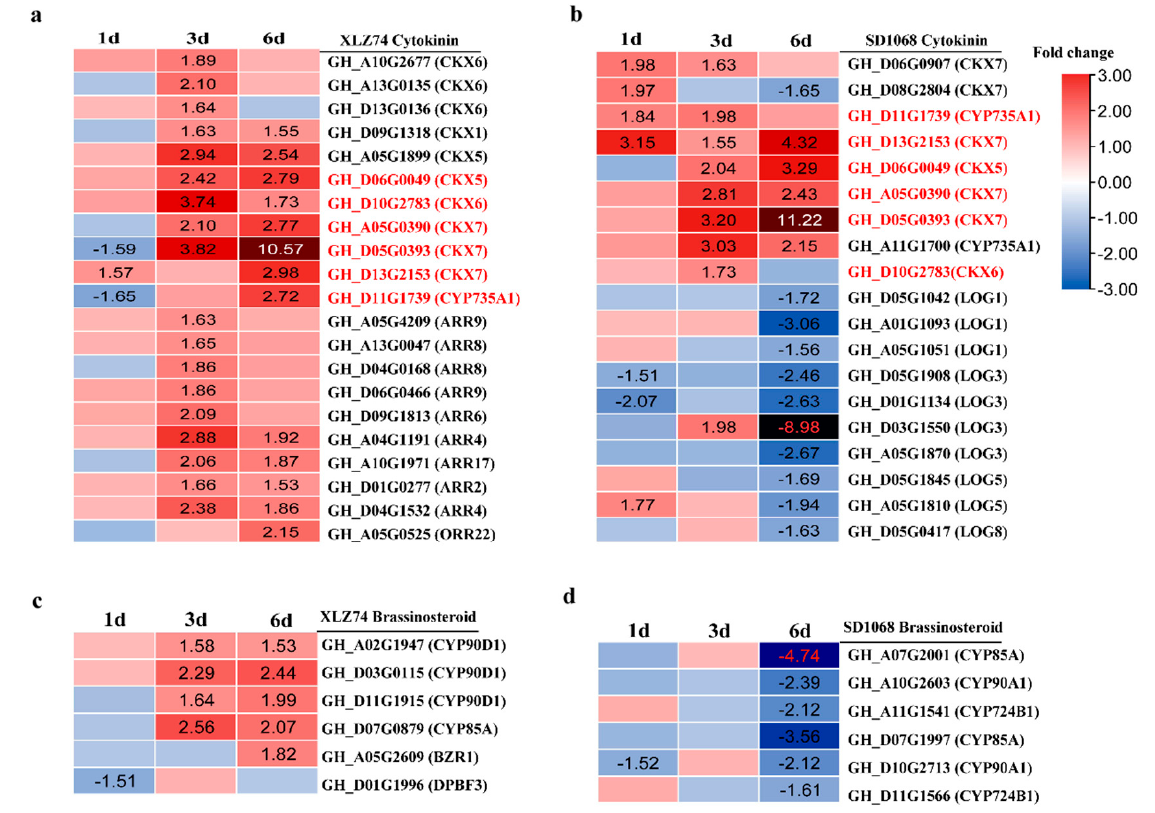
Figure 7. The expression patterns of CTK ( a , b )- and BR ( c , d )-related genes in XLZ74 and SD1068. The results were based on the RNA-seq data. The number in box indicates the expression fold change of the gene (only those with a ≥ 1.5-fold difference are shown). MC-induced downregulated and upregulated expression are indicated by blue and red colors, respectively. Gene ID marked with red represents common gene between XLZ74 and SD1068. All the numbers in heatmap were fold change.